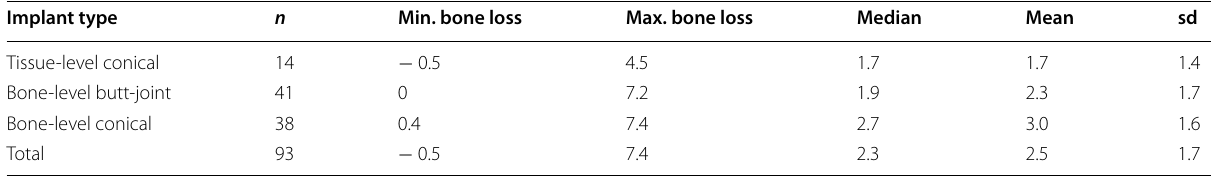
Presentation of minimal/maximal bone-level values at the end of the study (20 years) according to implant type sd standard deviation Table 7 Peri‑implant bone loss between 10 and 20 years Implant